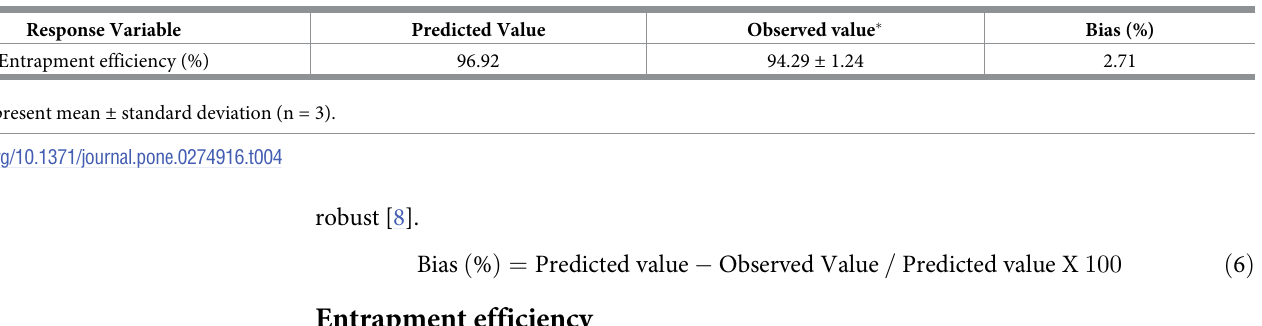
Table 4. Comparison of the observed and predicted values of HTN prepared under predicted optimum conditions.